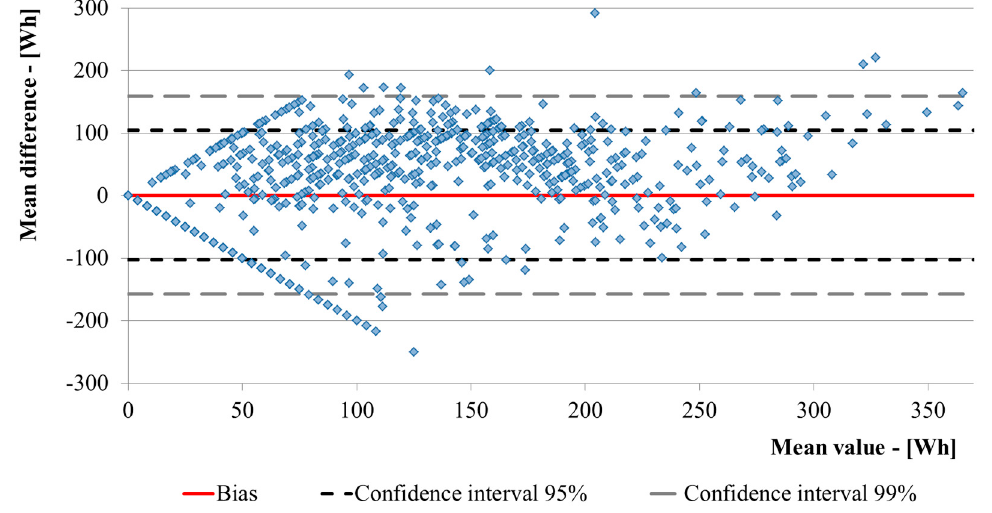
Figure 11. Bland ‐ Altman plot: energy consumption. Figure 11. Bland-Altman plot: energy